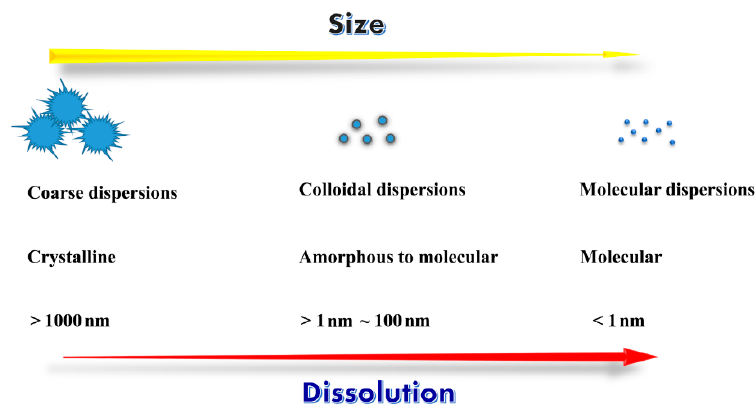
Figure 1. Dimension and physical properties of different kinds of dispersions.